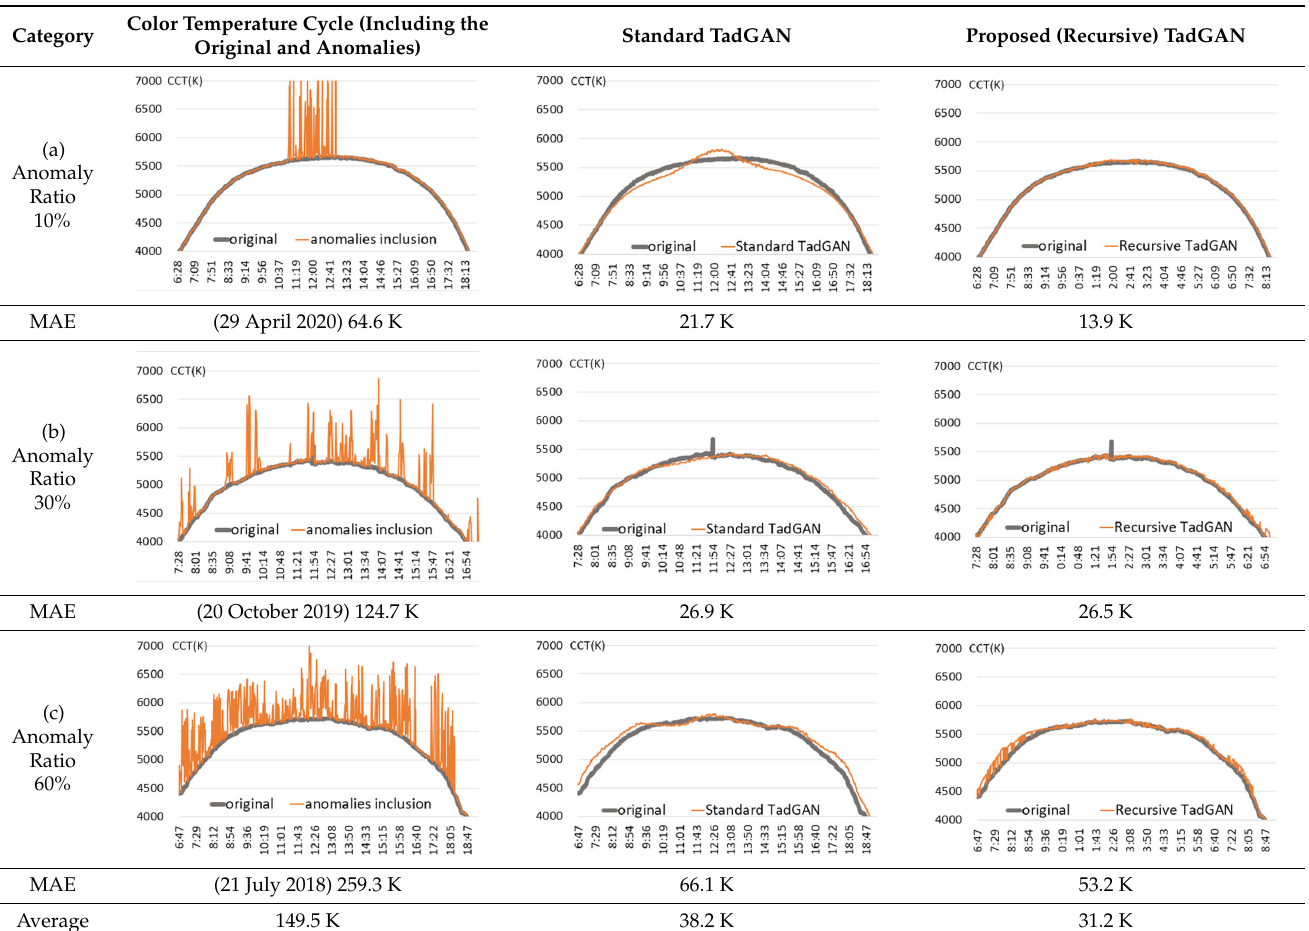
Table 1. Application results by applying the proposed TadGAN.